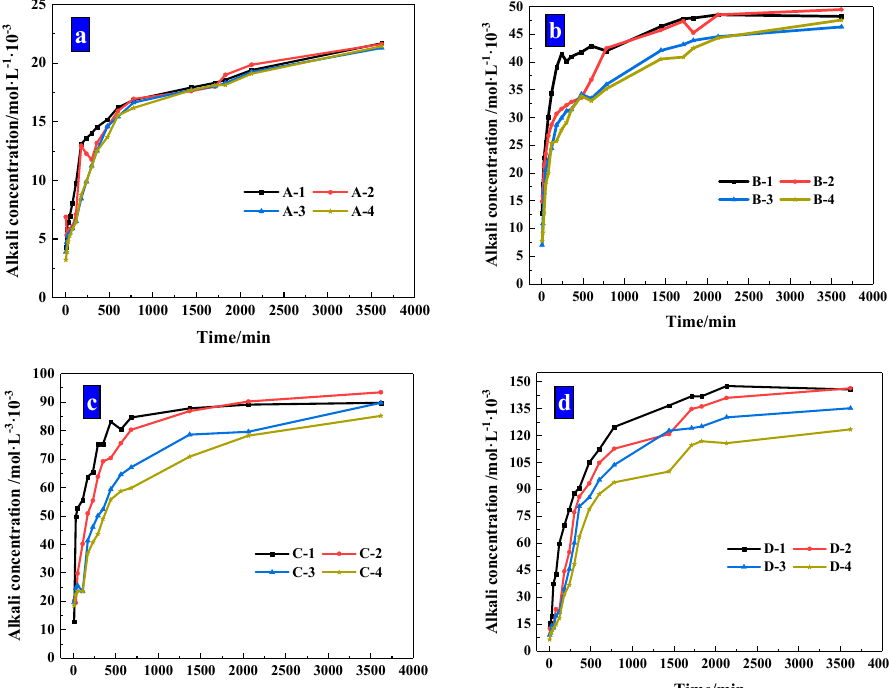
Figure 11. Release Rate of alkaline particles under different sizes. ( a ) Size range of 0.315–0.63 mm; ( b ) size range of 0.63–1.25 mm; ( c ) size range of 1.25–2.5 mm; ( d ) size range of 2.5–5 mm.